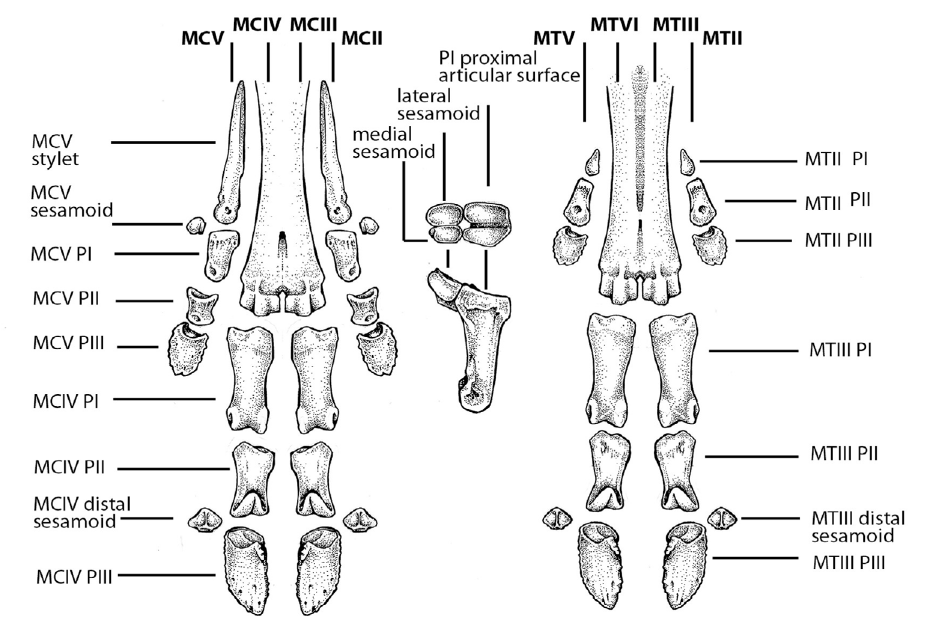
Figure 1. Metapodials, phalanges, and dewclaws, designated by metacarpal/metatarsal and phalanx number. Fore- limb is pictured on the left and hindlimb on the right, with proximal sesamoids depicted in the center. (Both il- lustrations depict right limbs, although it should be noted that at this time there is no accurate test for determining right-limb from left-limb phalanges). Illustration by